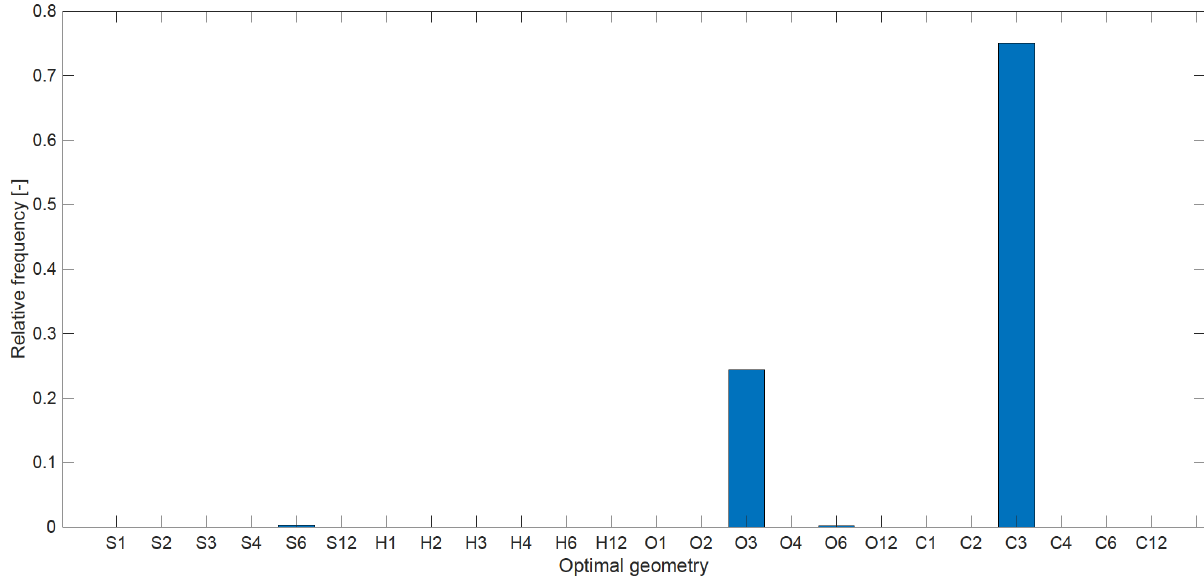
Figure 5: Optimal diagrid geometry based on 4096 simulations with different exponents of the individual desirability values